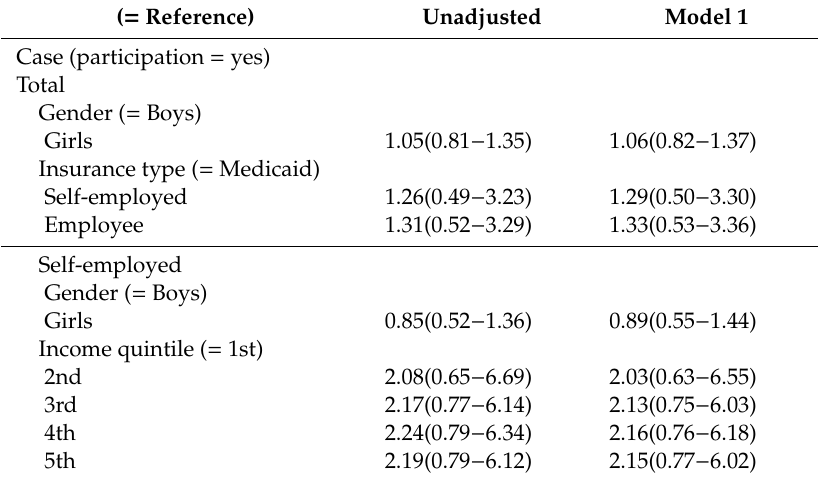
Table 4. Odds ratio and 95% CI estimated from panel logistic regression models for dental sealant in the NHISS by